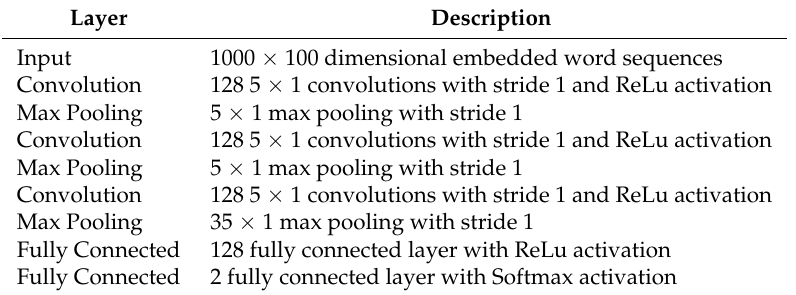
Table 2. CNN topology used in this work. The architecture was chosen after evaluating the accuracy on the test set using different kernel sizes, number of layers, activation functions,